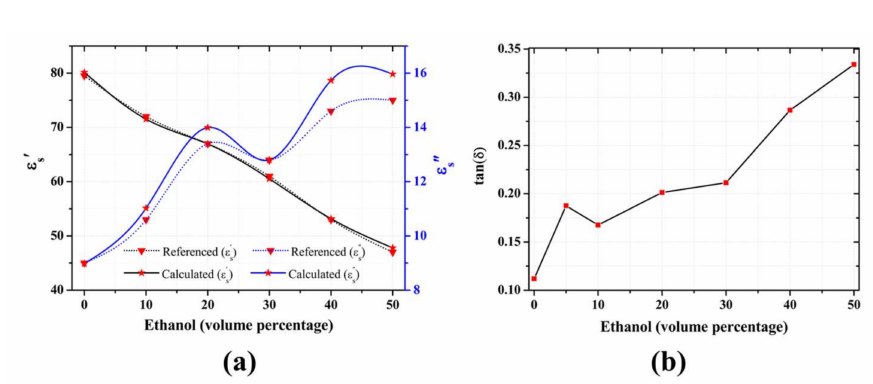
Figure 6. ( a ) Comparison between literature values (triangles) of the real (black) and imaginary (blue) complex permittivity and those obtained from the proposed sensor (stars); ( b ) Increased dissipation factor corresponding to the increase in ethanol